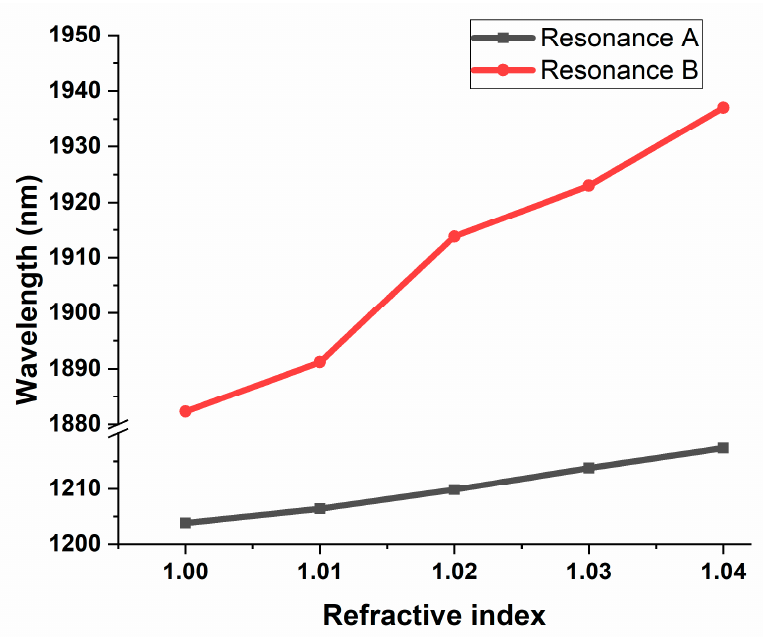
Figure 5. Resonances A and B shifts vs. refractive index change.